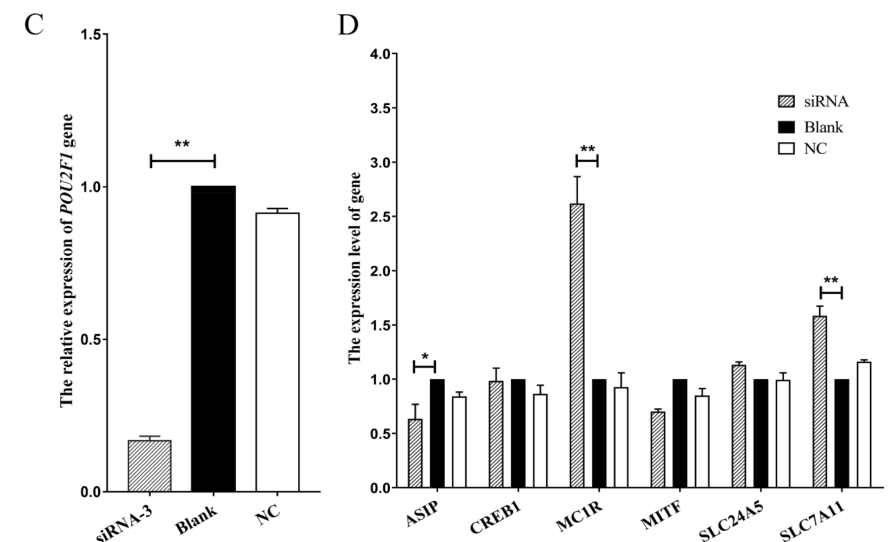
Figure 5. Expression levels of SLC7A11 and other pigmentation-related genes after the overexpression and interference of POU2F1 . ( A , C ) are the relative gene expression levels of POU2F1 in rabbit melanocytes transfected with pcDNA3.1( + )-Myc- POU2F1 vector and siRNA-3, respectively; ( B , D ) are the relative expression levels of other pigmentation-related genes in rabbit melanocytes transfected with pcDNA3.1( + )-Myc- POU2F1 vector and siRNA-3, respectively. The relative expression levels of the above genes were measured by RT-qPCR and calculated by the 2 − ∆∆ Ct method. * p < 0.05, ** p < 0.01, and *** p <